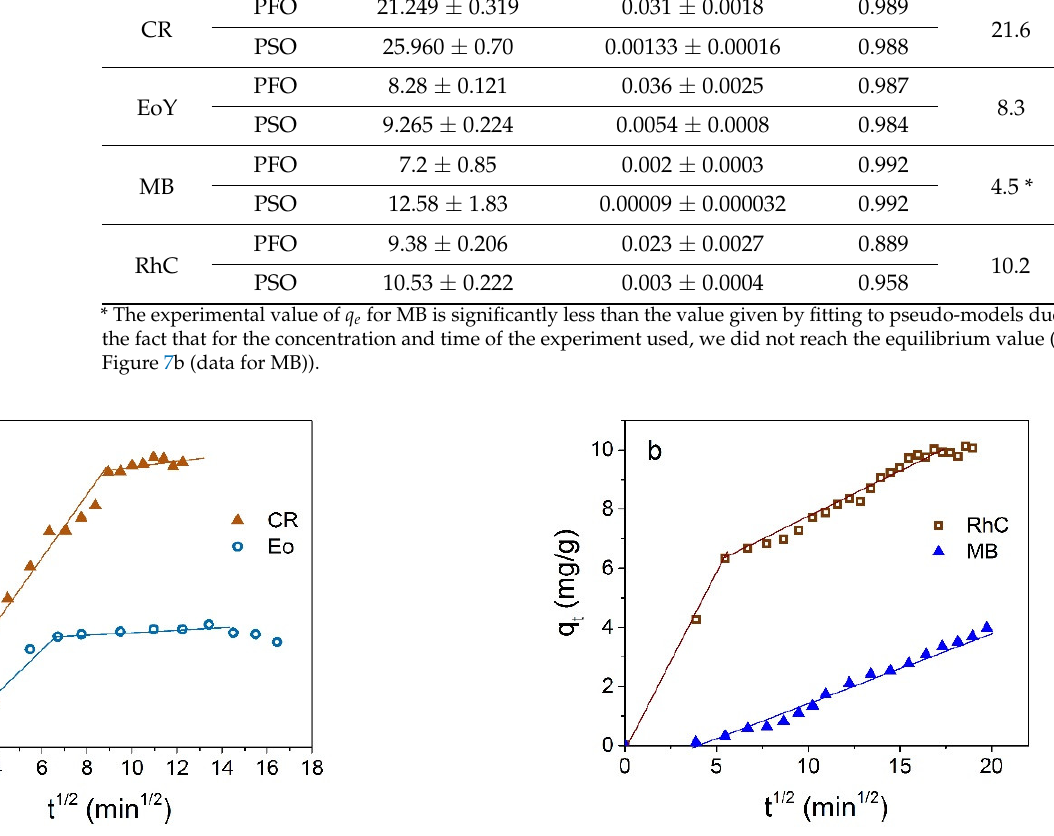
Figure 8. Representation of kinetic adsorption data of Fe 3 O 4 NPs in coordinates q t vs. t 1/2 for anionic ( a ) and cationic ( b ) dyes.